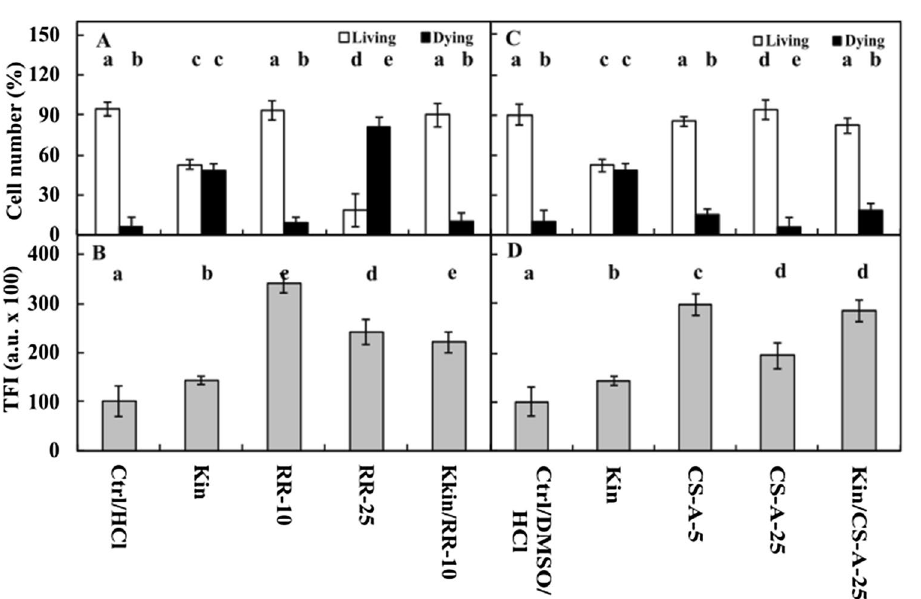
Figure 6. Number (%) of living and dying cells ( A , C ) as well as cytosolic calcium ion (Ca 2+ ) amounts ( B , D ) in the cortex of Vicia faba ssp. minor seedling apical roots after treatment with CS-A (cyclosporine A; A , B ) and RRed (ruthenium red; C , D ). The number of living and dying cells as well as the amounts of Ca 2+ were fluorescently estimated after staining with acridine orange, ethidium bromide and chlortetracycline. Bars indicate ± SE of the results from three biological replicates. The means of the results with the same letter above the column are not significantly different at p ≤ 0.05. Ctrl, control; DMSO, dimethyl sulfoxide; CS-A–5, 5 μM CS-A, cyclosporine A); CS-A–25, 25 μM CS-A; RRed–10, 10 μM, ruthenium red; RRed–25, 25 μM RRed; Kin, kinetin; Kin/CS-A, Kin with 25 μM CS-A; Kin/RRed–10,Kin with 10 μM RRed; TFI, total (integrated) fluorescence